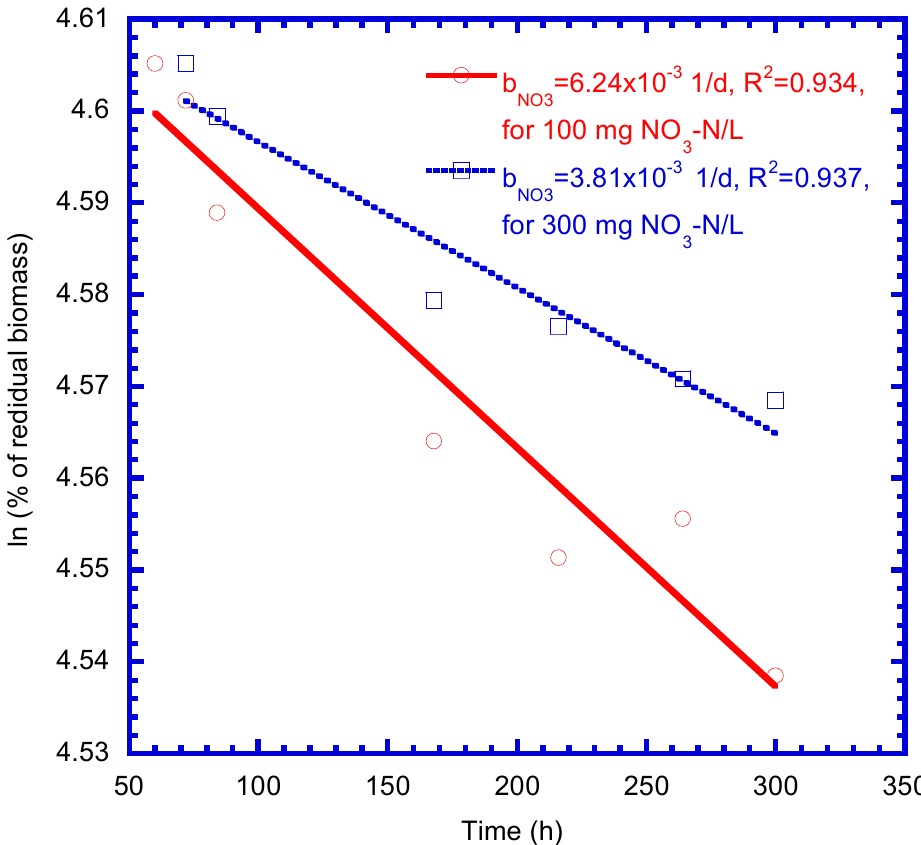
Figure 7. Batch kinetic tests to determine decay coefficient of denitrifying biomass at different initial nitrate concentrations of 100 and 300 mg NO 3 -N/L.